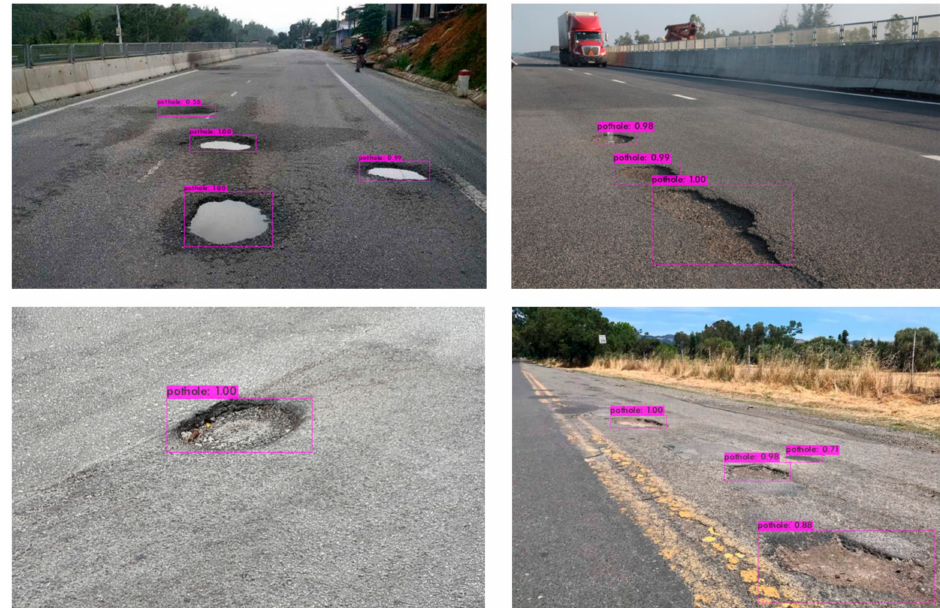
Figure 9. Detection outputs obtained by YOLOv4-tiny